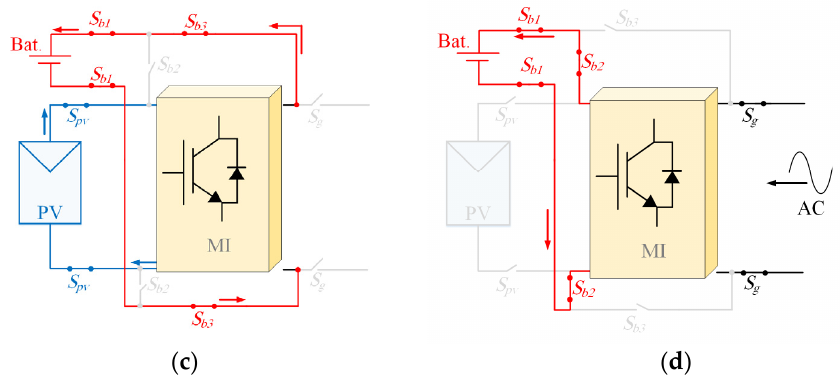
Figure 4. PV MCI with battery packs modes of operation: ( a ) DC/AC from PV to grid, ( b ) DC/AC from battery to grid, ( c ) DC/DC from PV module to battery, and ( d ) AC/DC from grid to battery.